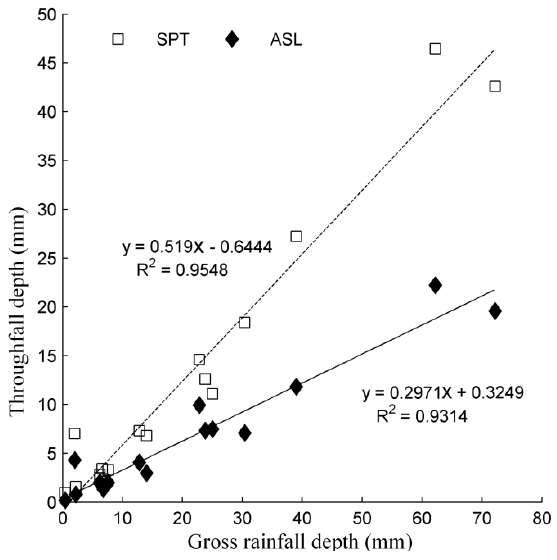
Figure 2. Linear regression between throughfall depth and rainfall depth.